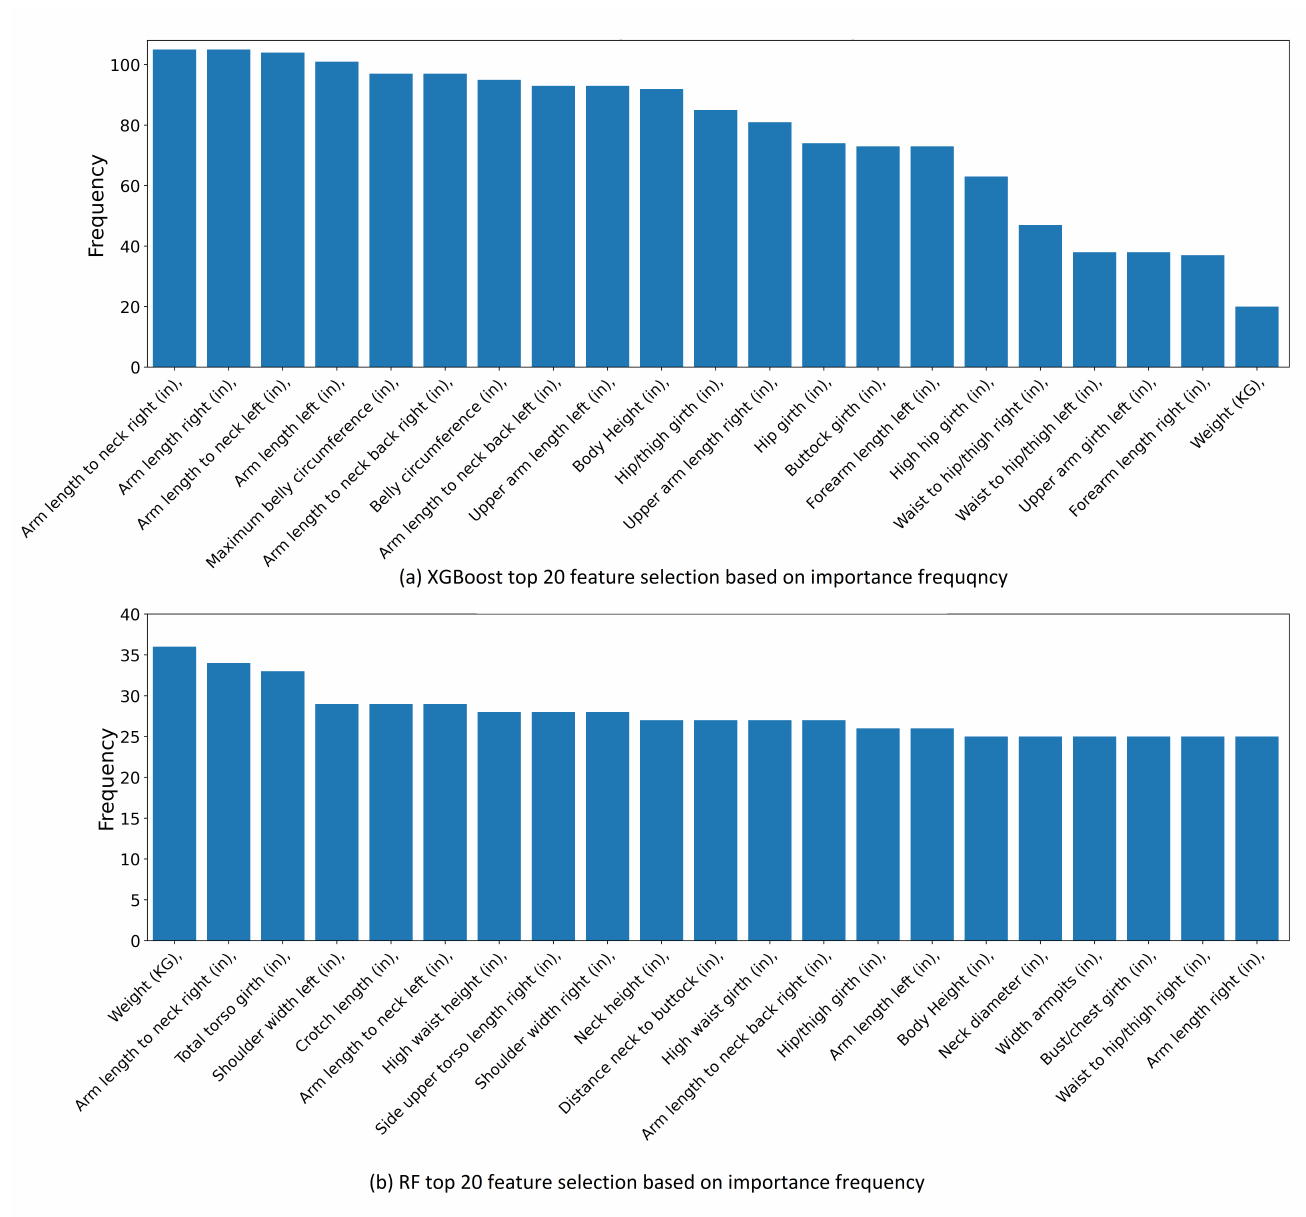
Figure 8. Top 20 most important body features by ranking feature